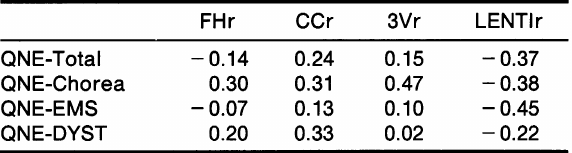
TABLE Va. Correlations between ONE movement impair ment indices and neuroanatomical atrophy in "early" HO (n = 11)